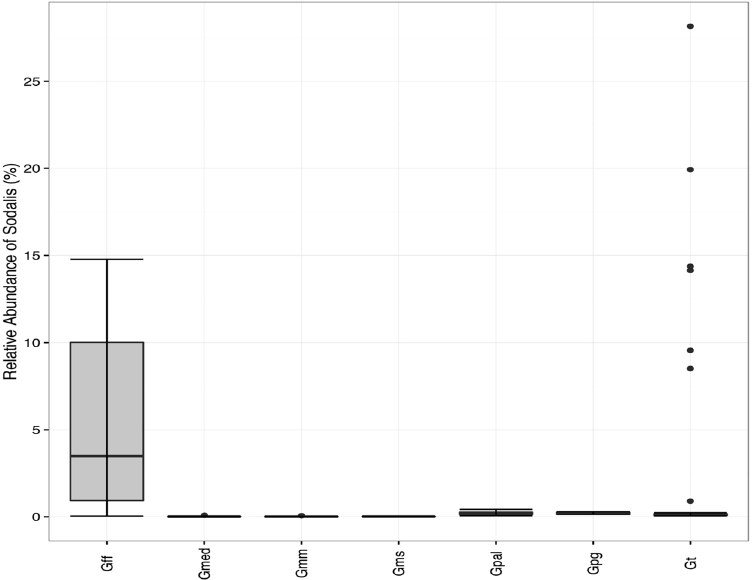
Figure 2. Sodalis relative abundance in each tsetse species. Boxes denote the interquartile range, the line within the box is the median, and whiskers extend to the most extreme value within 1.5 * interquartile range. Outliers are indicated as circles. Gff: G . fuscipes fuscipes (n = 76); Gmed: G . medicorum (n = 8); Gmm: G . morsitans morsitans (n = 6); Gms: G . morsitans submorsitans (n = 8); Gpal: G . pallidipes (n = 42); Gpg: G . p . gambiensis (n = 8); Gt : G . tachinoides (n = 8).